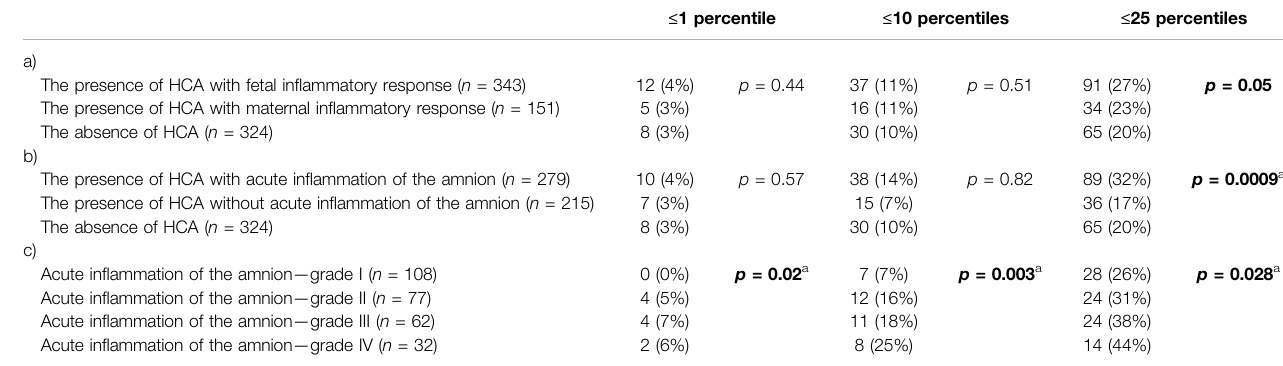
TABLE4| Therateofnewbornswithbirthweights,expressedaspercentilesderivedfromtheestimatedfetalweightstandards,thatwerelessthanorequaltothe fi rst,10th, and 25th percentiles according to: (a) the presence of HCA with fetal and maternal in fl ammatory responses and the absence of HCA; (b) the presence of HCA with and without acute in fl ammation of the amnion and the absence of HCA; and (c) severity of acute in fl ammation of the amnion (grades I-IV).